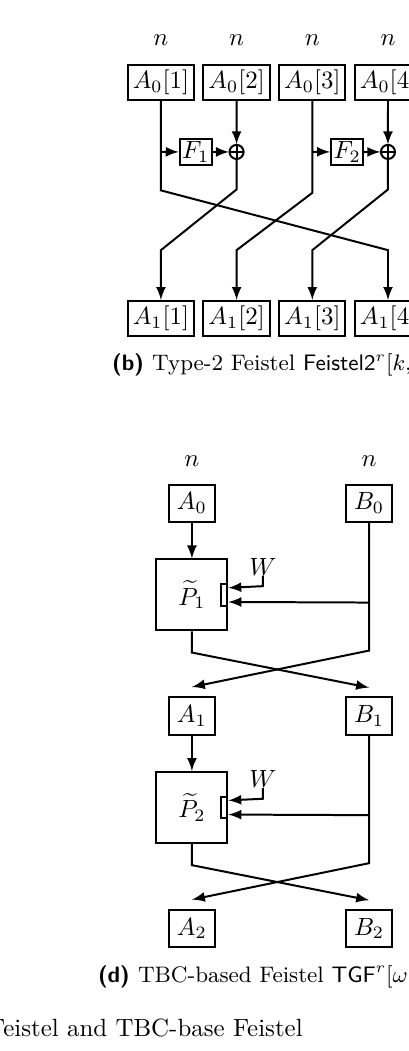
Figure 2: Type-1,2,3 Feistel and TBC-base